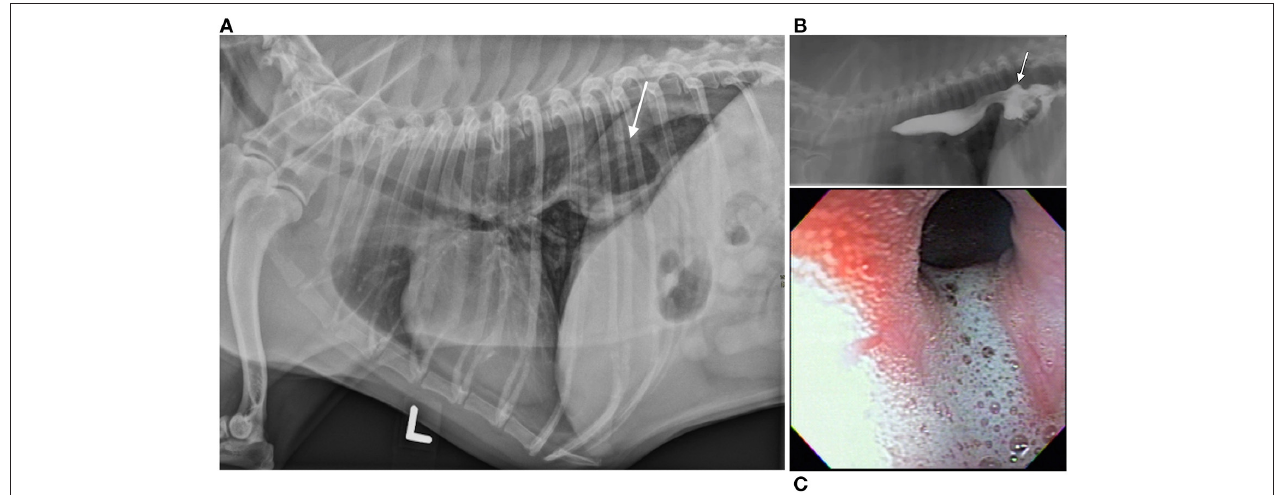
FIGURE 3 | Hiatal herniation, gastroesophageal reflux, and esophagitis in a brachycephalic dog. Hiatal herniation in a brachycephalic dog. (A) Left lateral thoracic radiograph of a 5-year old brachycephalic Boston Terrier with a chronic history of regurgitation. The stomach is seen extending through the diaphragm into the craniodorsal thorax in this image (arrow). Although not pictured, the stomach returns to a normal position on subsequent views, which is suggestive of a sliding or type I hiatal hernia. (B) Contrast videofluoroscopic swallow study of the same patient. This image documents gastroesophageal reflux of barium contrast as a result of hiatal herniation (arrow points to hiatal herniation and stream of white contrast extending cranial is evidence of gastroesophageal reflux). (C) Endoscopic image from the same patient showing foamy gastroesophageal reflux cranial to the lower esophageal sphincter and secondary esophagitis [reddened hyperemic area in the upper left of the image (denoted with arrow)]. (A–C) Images were published in Textbook of veterinary internal medicine: diseases of the dog and the cat, Vol 2, 8th edition, Marks SL, Chapter 273: Diseases of the Pharynx and Esophagus, 8501–8576, Copyright 2017 by Elsevier, Inc, Reprinted with permission from